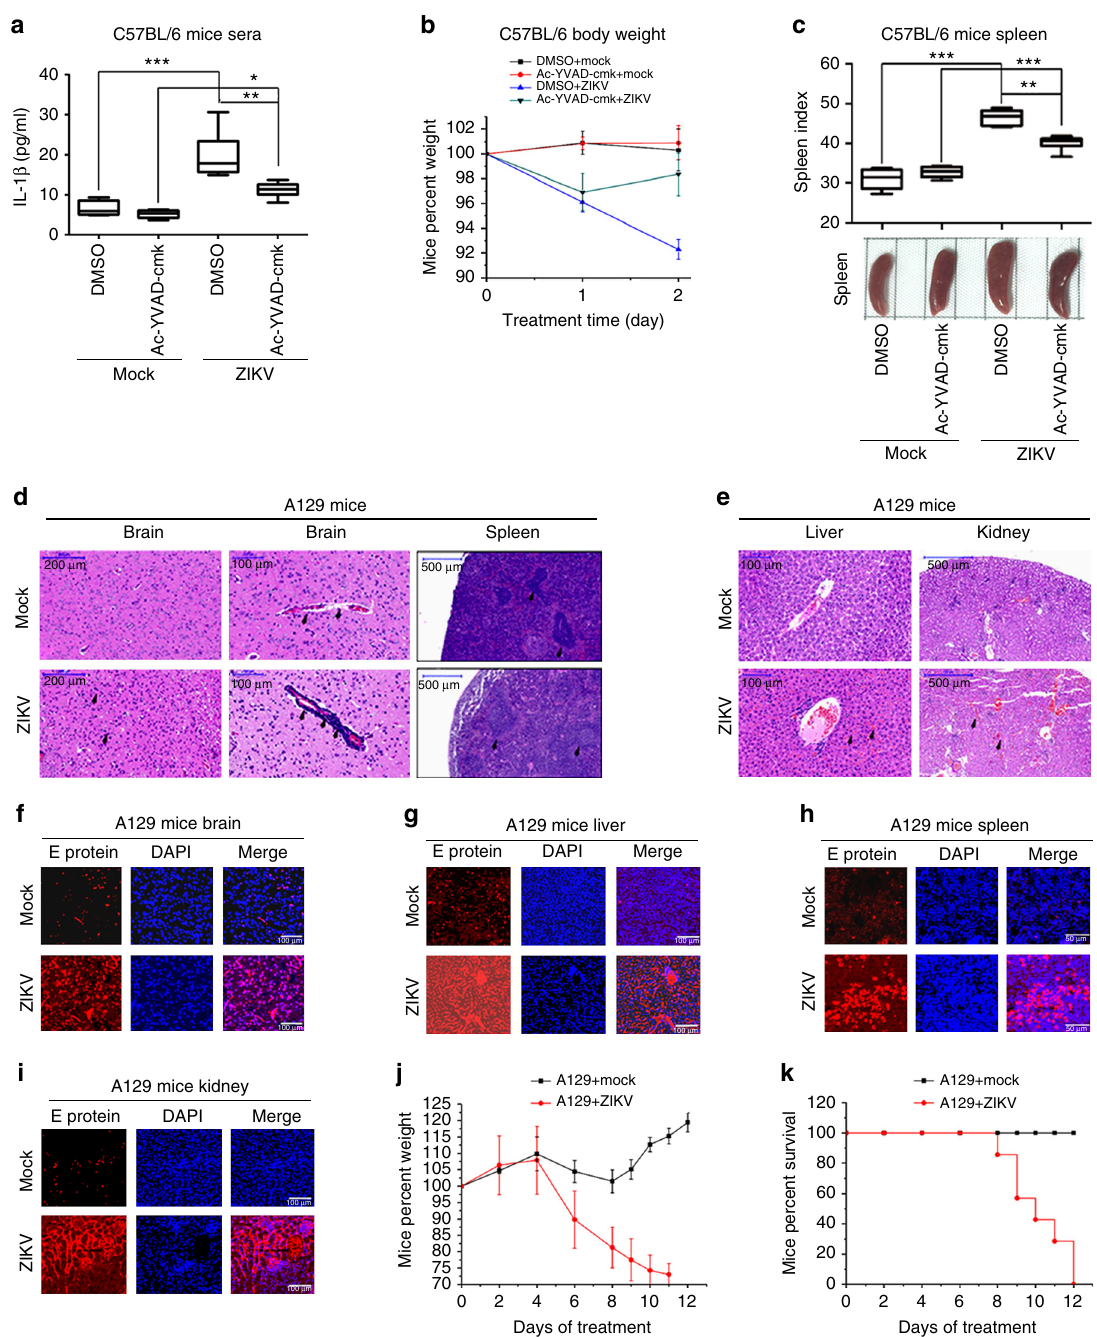
Fig. 7 The effects of ZIKV infection on the induction of in fl ammatory responses in mice. a – c C57BL/6 WT mice (5 weeks old, male) were pretreated with DMSO ( n = 6) or Ac-YVAD-cmk (8 mg/kg) ( n = 6) by intraperitoneal injection for 30 mice and then infected with ZIKV (5 × 10 5 PFU) ( n = 6) or treated with PBS ( n = 6) for 2 days. At 0, 1, and 2 days posttreatment, the levels of IL-1 β protein in mice sera were determined by ELISA ( a ) and the mice body weights were evaluated ( b ). Data shown are whiskers: Min. – max.; * P < 0.05, ** P < 0.01, *** P < 0.0001 (one-way ANOVA with Tukey ’ s post-hoc test) ( a ). Data shown are means ± s.e.m ( b ). At 2 days posttreatment, the splenomegaly and splenic index (spleen weight (mg)/body weight (g) × 10) of treated mice was evaluated ( c ). Data shown are whiskers: Min. – max.; ** P < 0.01, *** P < 0.0001 (one-way ANOVA with Tukey ’ s post-hoc test). d – k A129 mice (6 weeks old) ( n = 7; 4 males and 3 females) were infected with ZIKV (5 × 10 5 PFU) for the indicated times. A129 mice (6 weeks old) ( n = 3; 2 males and 1 female) were treated with PBS as Mock-infection. d – i At 10 days posttreatment, mice brain tissue ( d ) and spleen tissue ( e ) were stained with hematoxylin and eosin (H&E) and examined using a light microscope, and the sections of mice brain tissue ( f ), spleen tissue ( g ), liver tissue ( h ), and kidney tissue ( i ) were stained with DAPI to label nuclei (blue) and an antibody against ZIKV E protein (red) and examined by confocal microscopy. Scale bar of the brain (left) is 200 μ m. Scale bar of the brain (right) is 100 μ m. Scale bar of the spleen is 500 μ m ( d ). Scale bar of the liver is 100 μ m. Scale bar of the kidney is 500 μ m ( e ). Scale bar is 100 μ m ( f – i ). ( j , k ) At 0, 2, 4, 6, 8, 10, and 12 days posttreatment, the mice body weights ( j ) and survival rates ( k ) were evaluated. Data shown are means ± s.e.m ( j